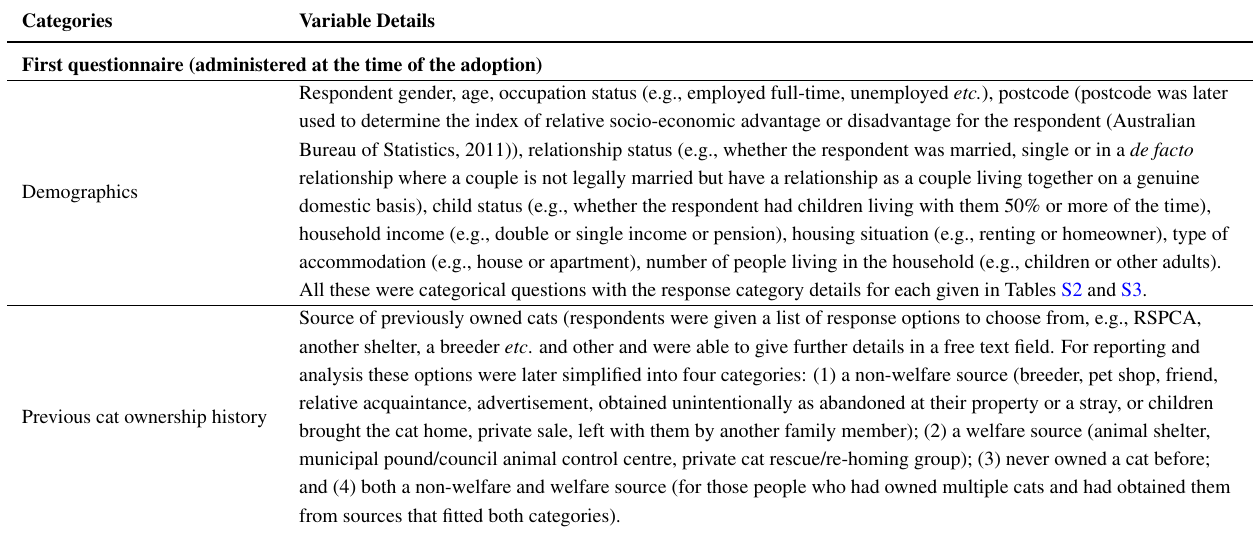
Table S1. Questionnaire categories and data variable